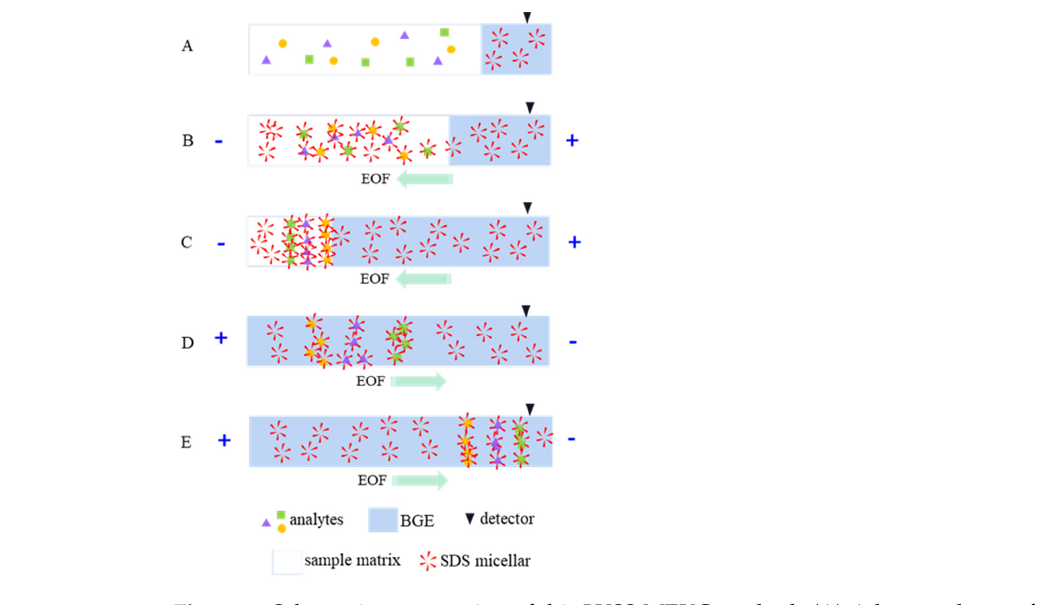
Figure 6. Schematic presentation of this LVSS-MEKC method. ( A ) A large volume of a sample is injected hydrodynamically. ( B ) SDS micelles transported together with the analytes migrate rapidly toward the outlet end. ( C ) The analytes were enriched and arranged in order of pKa values. ( D ) The sample matrix was pumped out from the inlet and the analytes started to separate. ( E ) The analytes migrated to the detector according to the value of pKa.